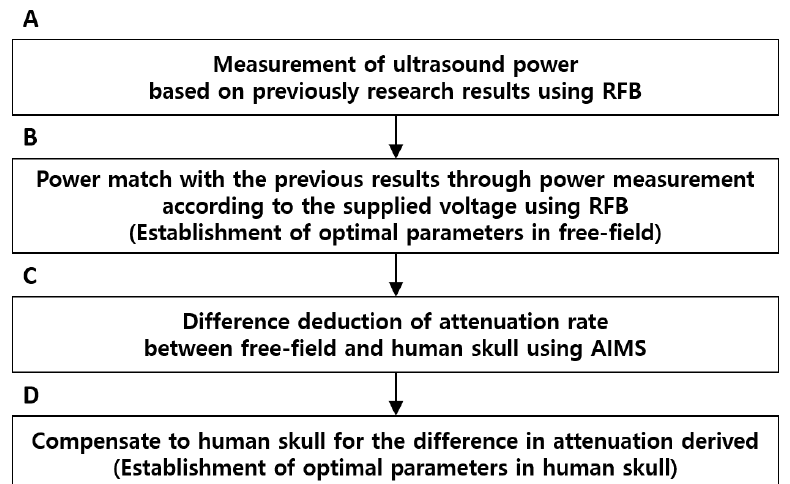
Figure 2. Flow chart for the derivation of optimal ultrasound parameters according to the existence of the human skull. ( A ) Power level derivation of 1 MHz FUS transducer using safe BBBD pressure proven by the previous study. ( B ) Deduction of an optimal supplied voltage of the 250 kHz FUS transducer to match the power of the 1 MHz FUS transducer. ( C ) Measurement of the ultrasound attenuation rate induced by the human skull. ( D ) Free field as much as the attenuation induced by the human skull.